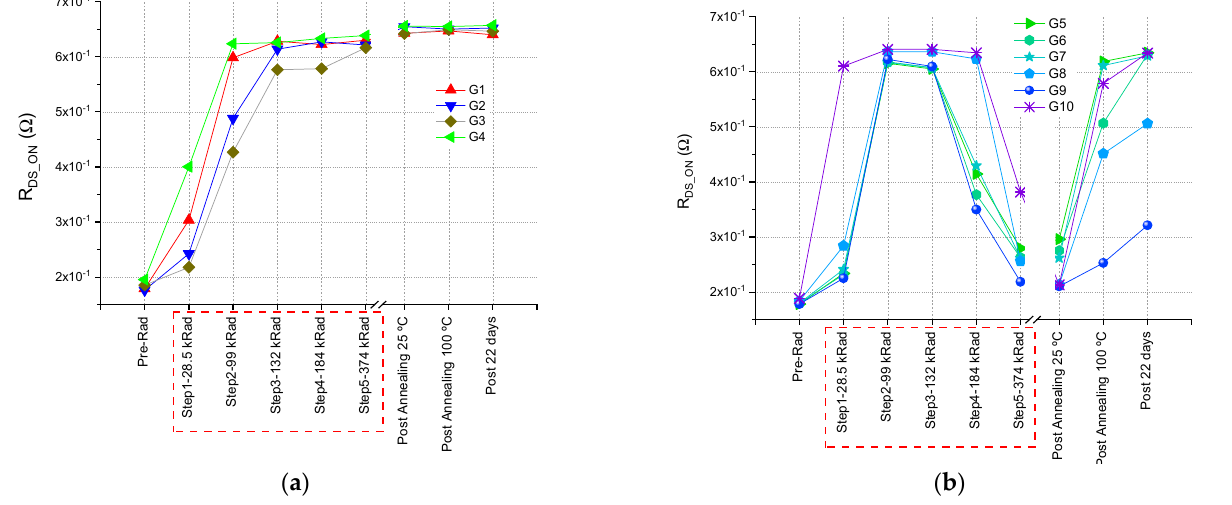
Figure 10. The R ON double pulse measurements: ( a ) devices G1–G4, which were irradiated at 133 °C; ( b ) devices G5–G10, which were irradiated at 53 °C.